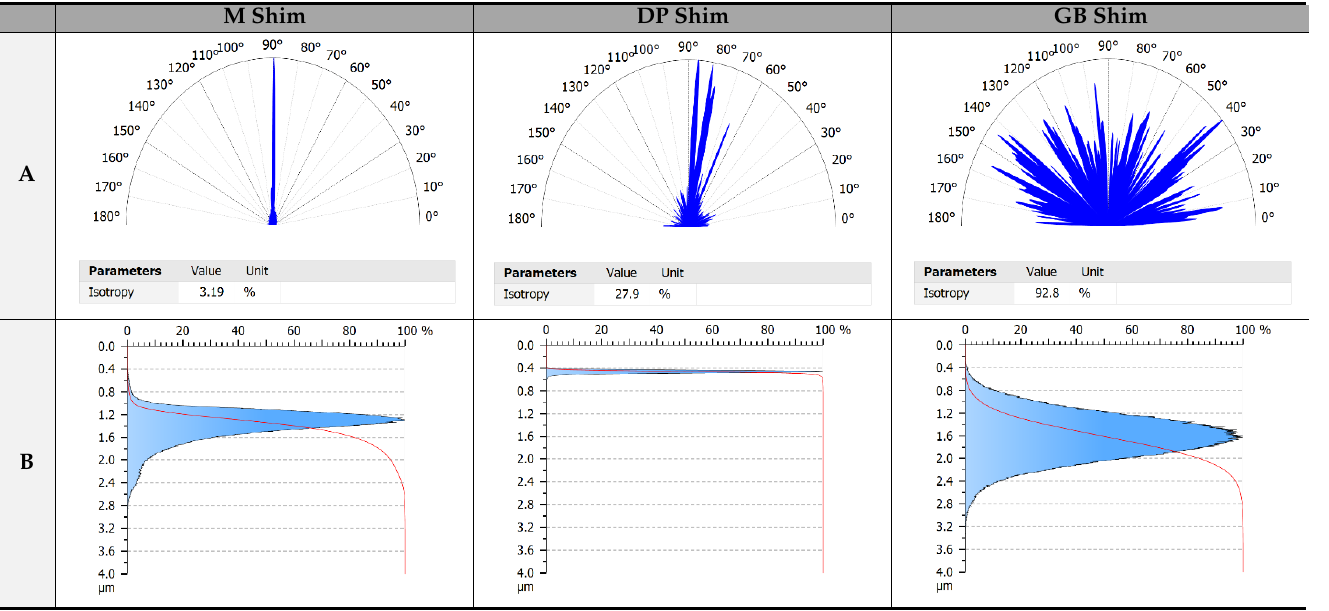
Table 3. Height (amplitude) parameters of surface roughness (S-L) for different shims. For each parameter, four measurements were